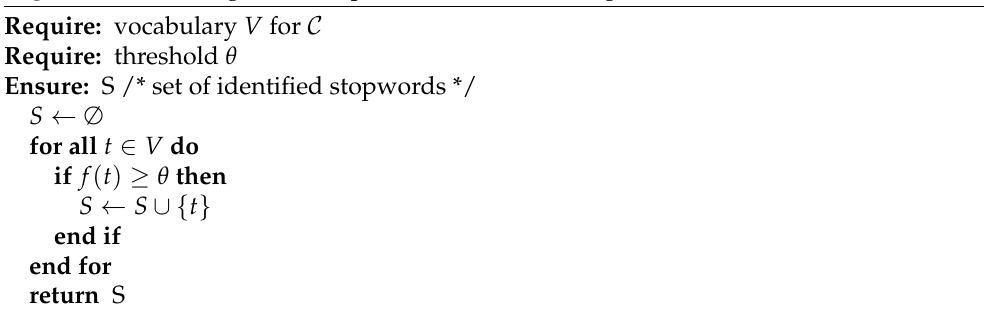
Algorithm 1 Ranking-based stopword identification